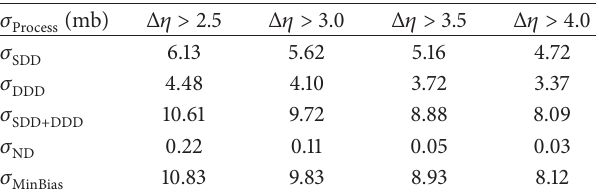
Table 2: Visible cross sections for different Δ𝜂 cuts. A cut of 𝑝 T > 200 MeV is applied for all final state particles in |𝜂| < 5.2 and the gap is defined as edge